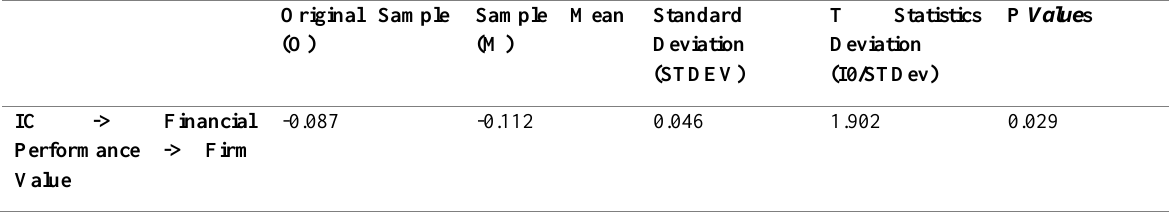
Table 3 : Output of Spesific Indirect Effects